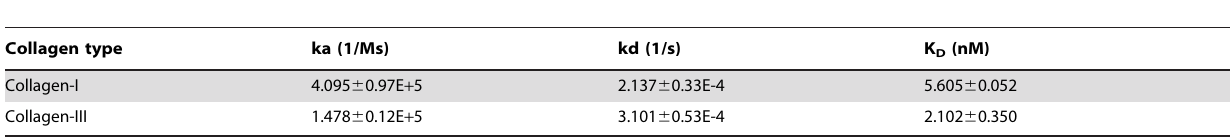
Table 1. Surface plasmon resonance analysis of Simplagrin-collagen